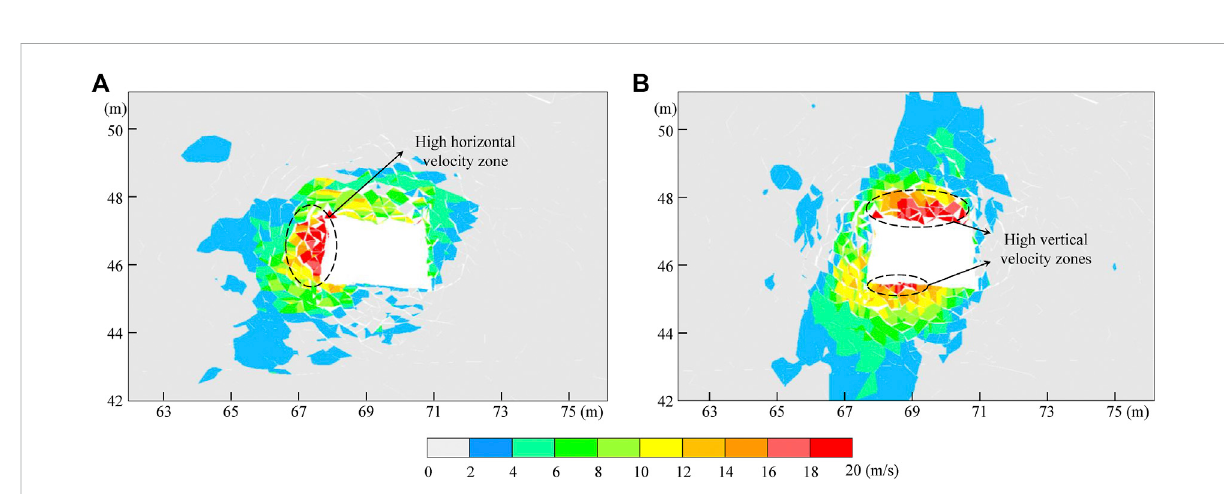
FIGURE 11 Ejection velocities of fragments in the MSTCB: (A) the horizontal ejection velocity, and (B) the vertical ejection